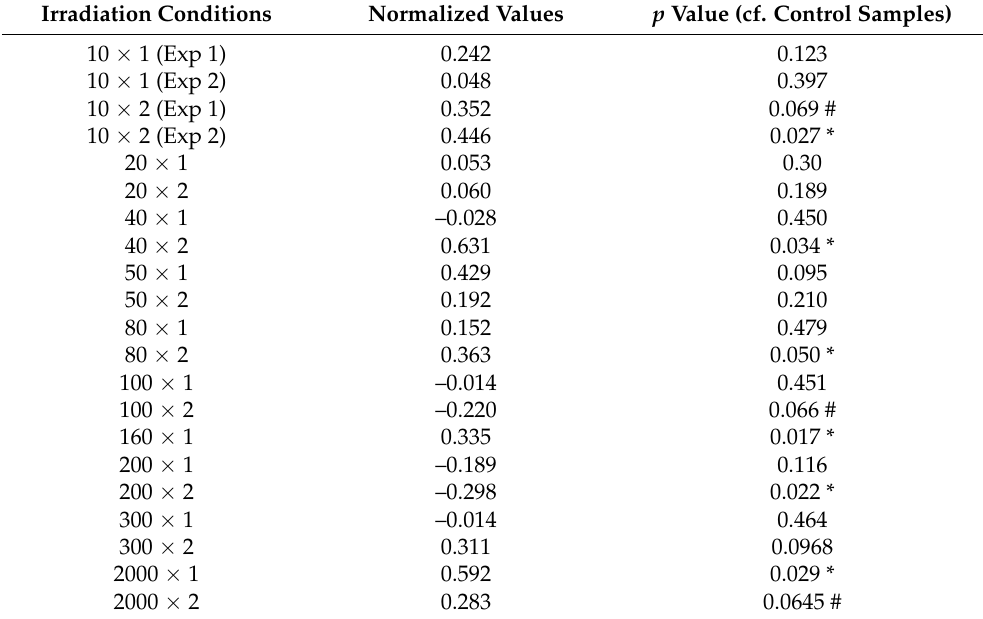
Table 2. Data extracted from ref. [54]. Normalized values (normalized average numbers of apoptotic signals with respect to the average of the corresponding control samples) for 25 hpf zebrafish embryos that were exposed to different irradiation conditions at the two-cell stage (0.75 hpf). Irradiation conditions: first number represents the number of protons irradiated onto one cell of a two-cell stage zebrafish embryo; ( × 1) and ( × 2) represent one or both of the cells, respectively, were irradiated; (Exp 1) and (Exp 2) refer to two separate experiments. The numbers of apoptotic signals are compared with those detected on control samples, and the p values are obtained using t